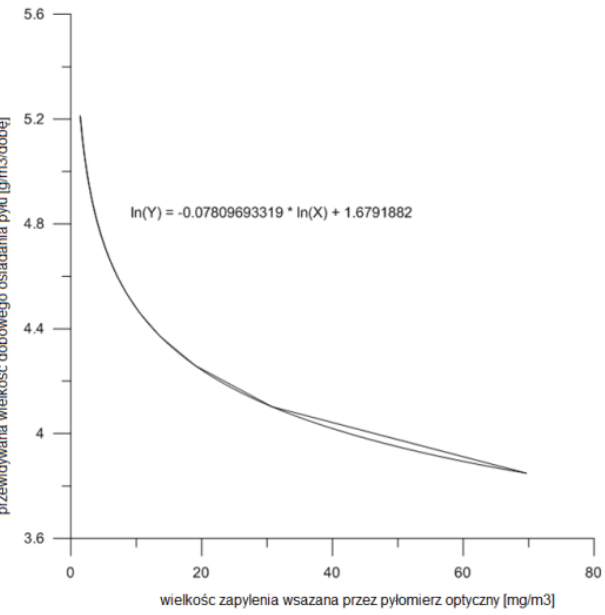
Figure 2. Empirical model of dust settlement in relation to dust concentration in air for longwall panel no. 551 and longwall no. 121 [11].